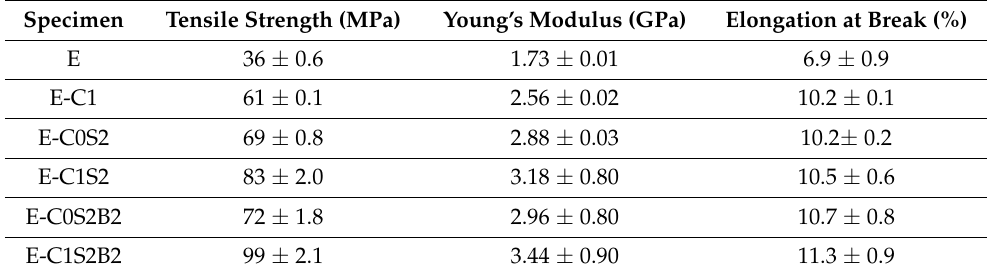
Table 3. Tensile properties of epoxy and multiscale composites. Specimen